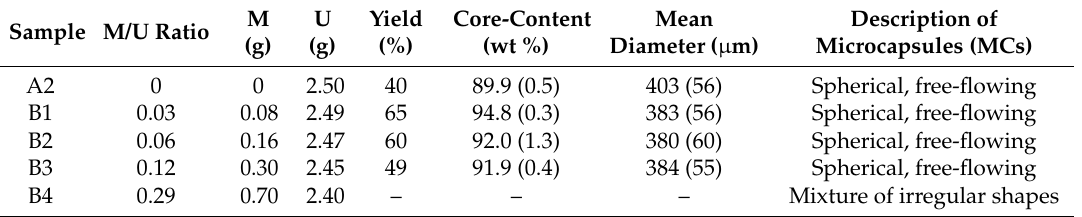
Table 3. Characterization data for alkyd microencapsulation.